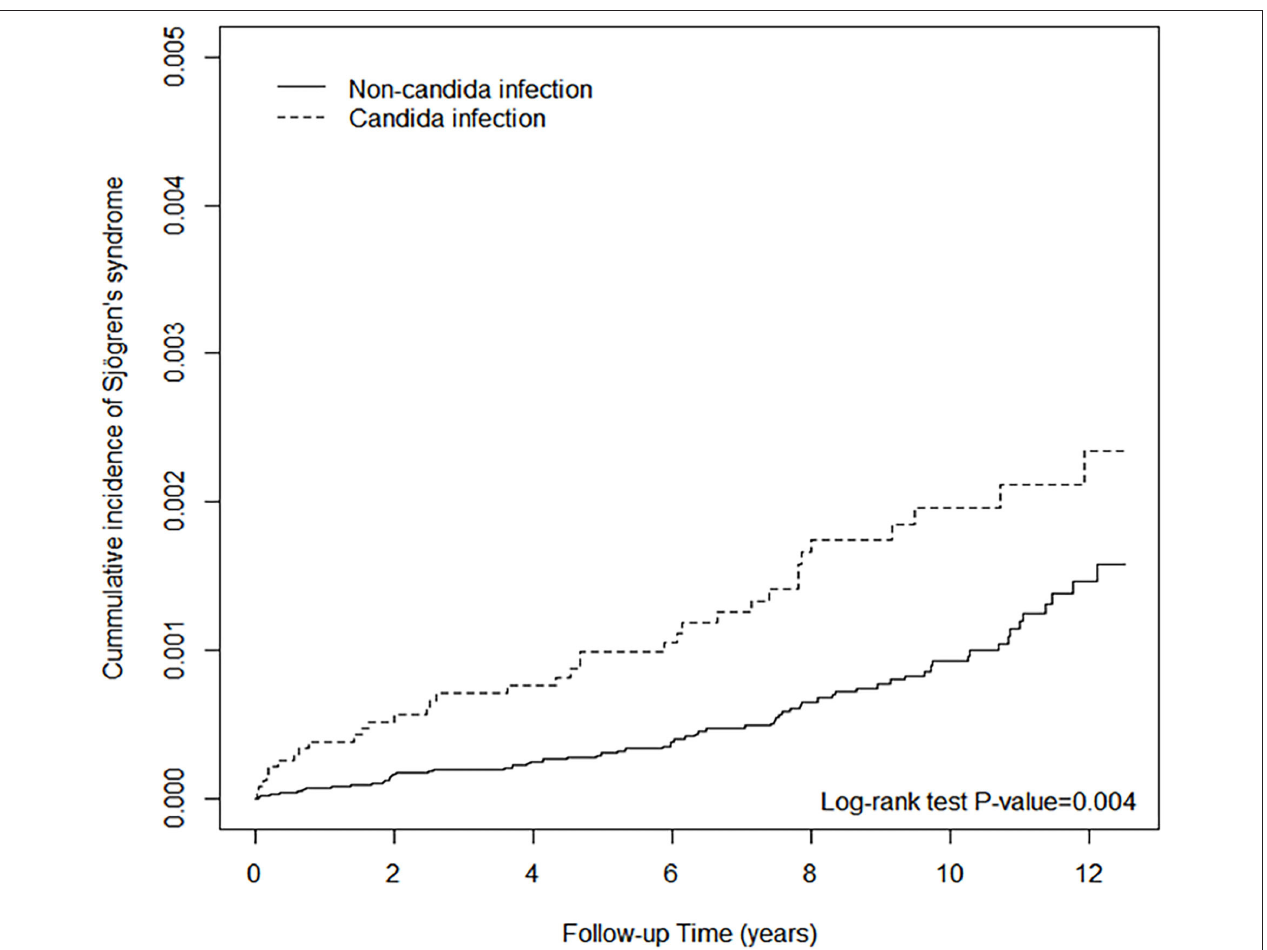
FIGURE 1 | The cumulative incidence of Sjögren’s syndrome of non- Candida infection and Candida